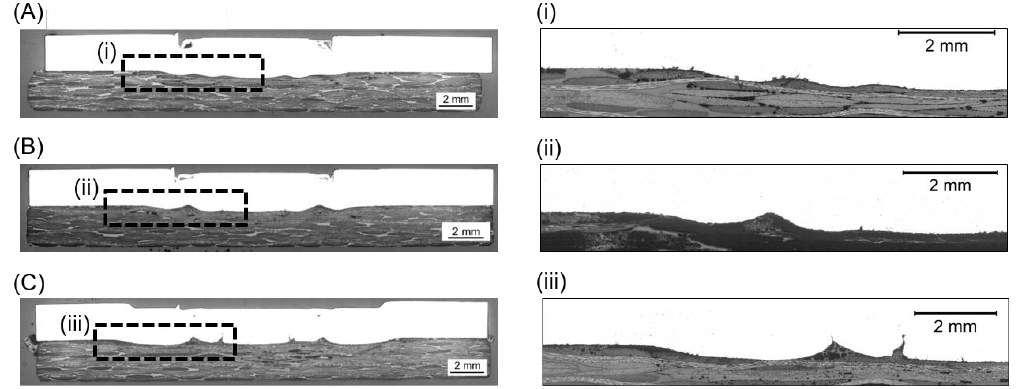
Figure 9. Cross-sections of friction spot joints produced with ( A ) 4 kN, ( B ) 6 kN, and ( C ) 8 kN. Details of the metallic nubs are given in ( i ), ( ii ) and ( iii ) for the joints produced with 4, 6 and 8 kN respectively (constant joining parameters RS: 1900 rpm, PD: 0.8 mm, JT: 4 s).